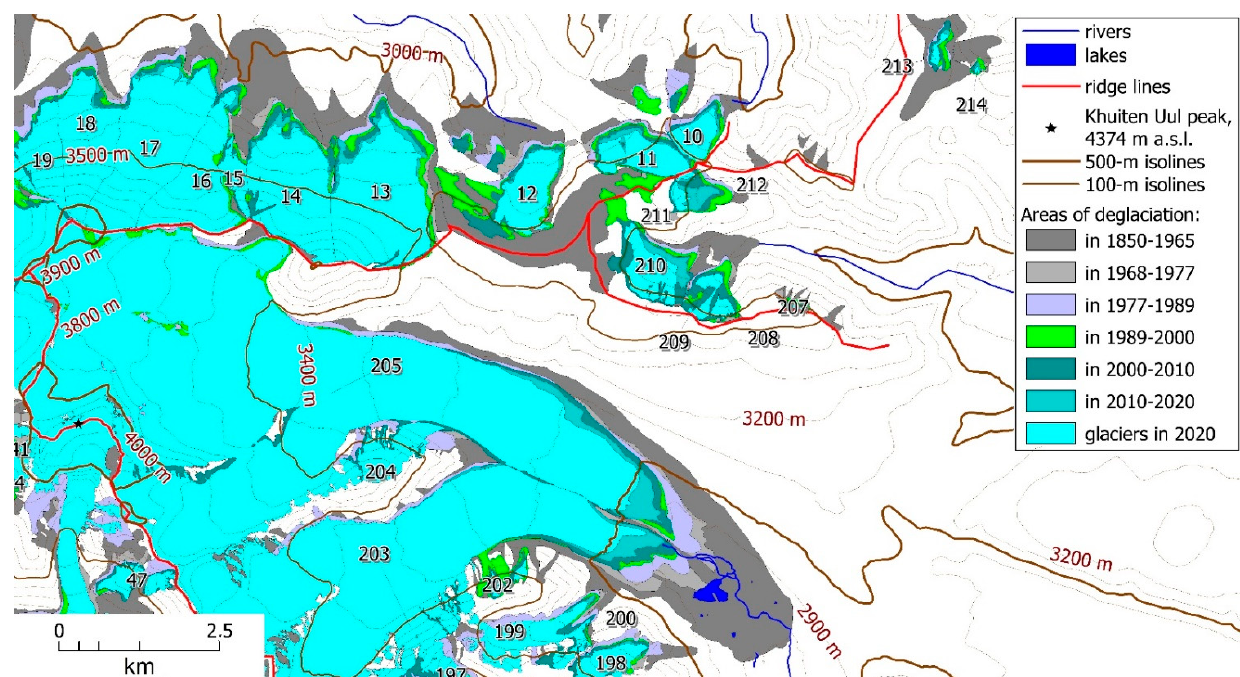
Figure 7. Glacier recession in the Tavan Bogd massif after the LIA maximum, a fragment from the north-east part.